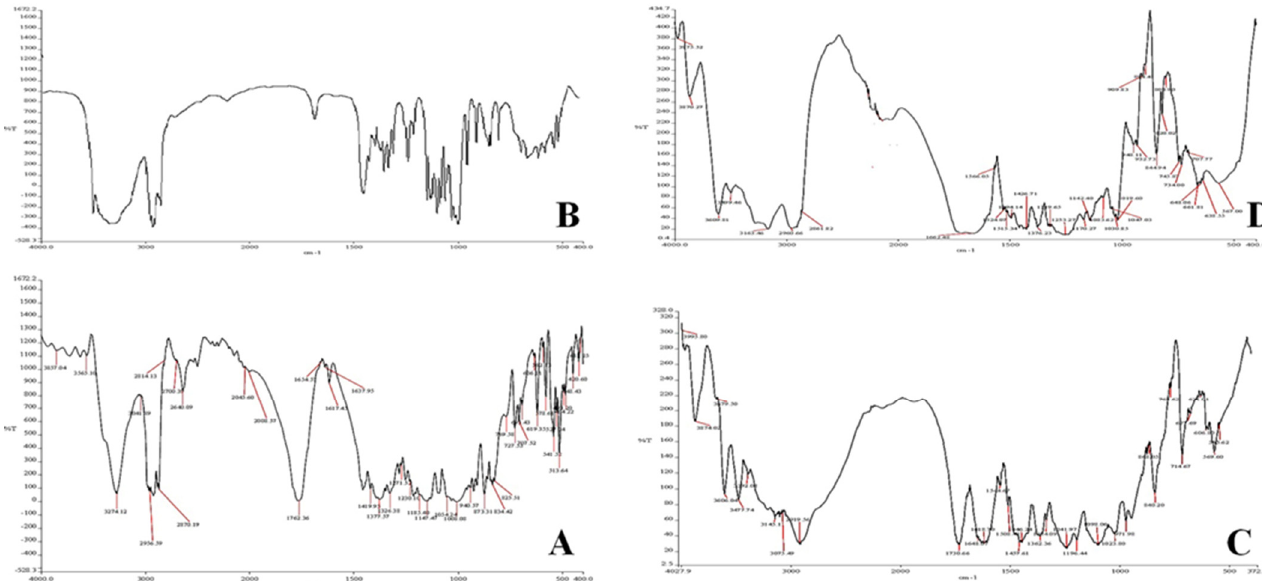
Figure 2. FT-IR Spectra of pure cytarabin ( A ), trehalose ( B ), cytarabine-loaded TINPs (CY-TINPs) ( C ), Figure 2. FT ‐ IR Spectra of pure cytarabin ( A ), trehalose ( B ), cytarabine ‐ loaded TINPs (CY ‐ TINPs) ( C ), and CY ‐ TINPs ( D ) after 3 months. and CY-TINPs ( D ) after 3 months.